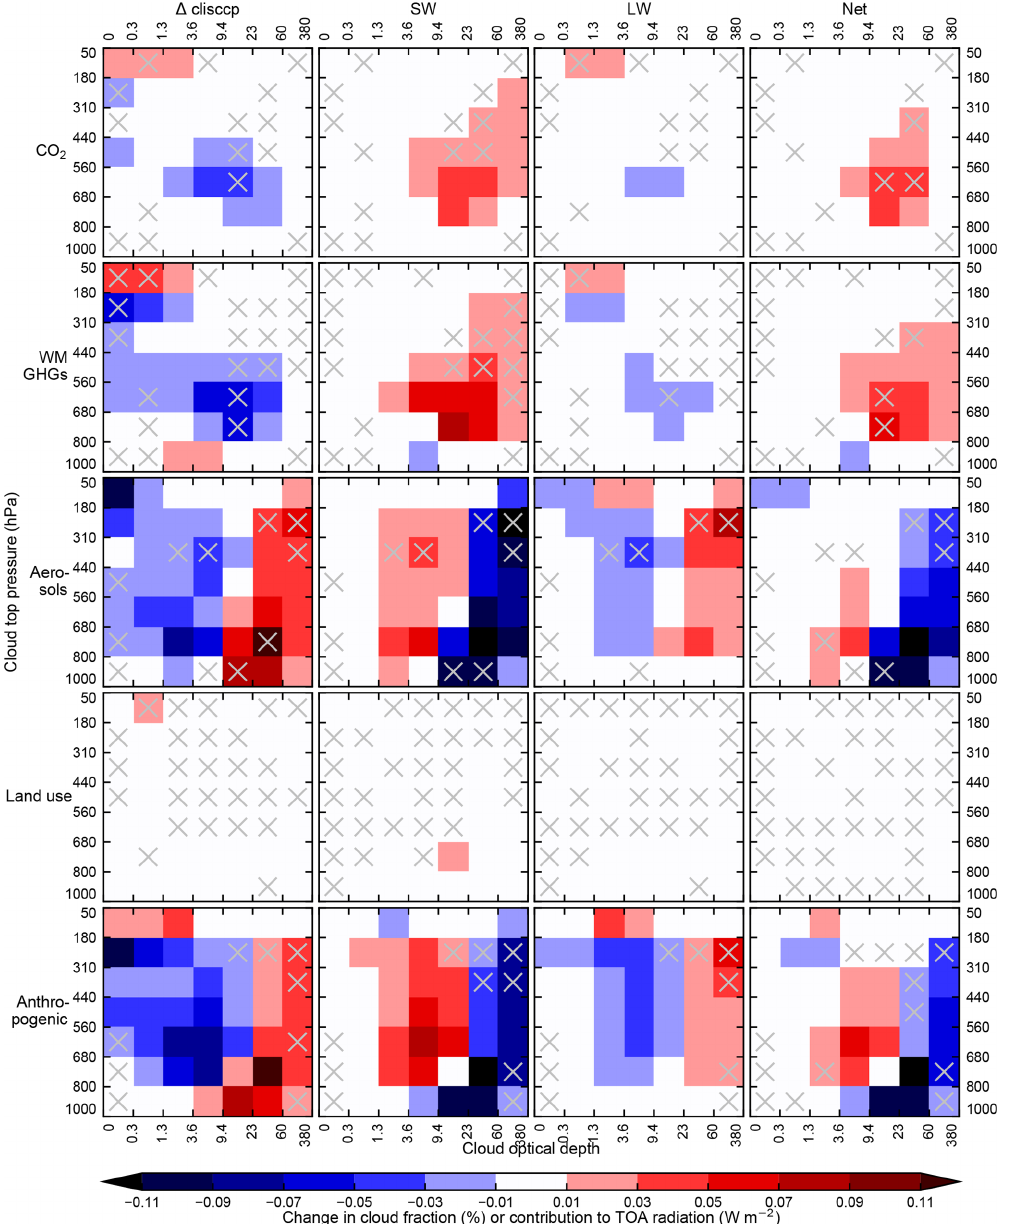
Figure 4. Global-mean change in ISCCP-simulated cloud fraction (clisccp) in CTP- τ space (first column) and consequential changes in SW (second column), LW (third column) and net (fourth column) radiation when convoluted with the ISCCP cloud kernel. Grey crosses show where less than 75% of models agree on the sign. Figure shows the multi-model mean cloud fraction and radiative effect. For 1 . 4 × CO 2 the change in cloud fraction, as well as the radiative fluxes, is scaled down from the 4 × CO 2 experiment using Etminan et al.